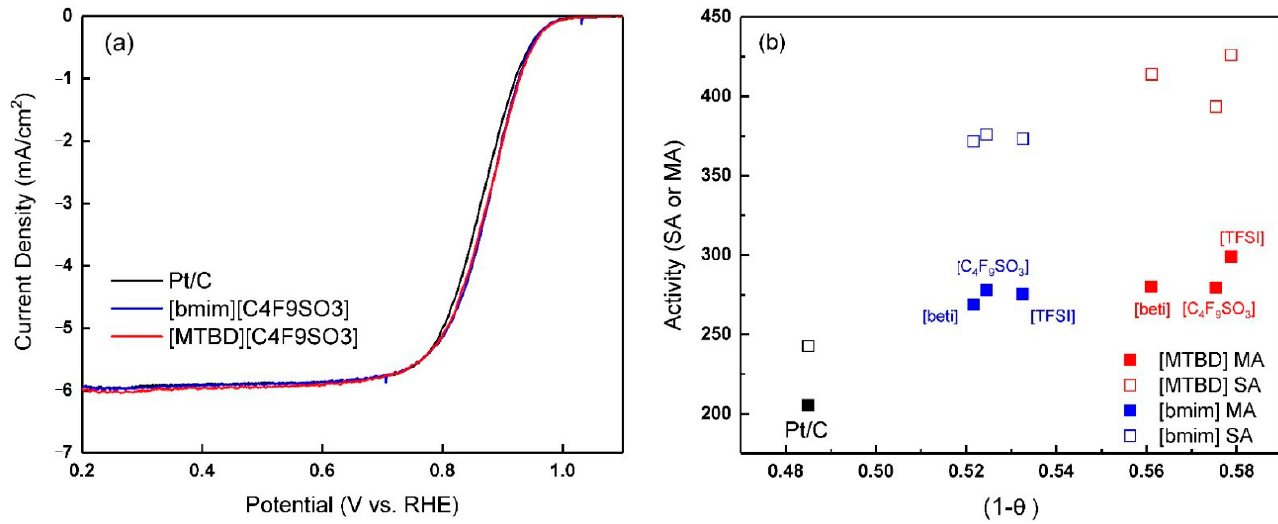
Figure 8. ORR activity measurements. ( a ) Polarization curves of Pt/C, Pt/C-[bmim] [C 4 F 9 SO 3 ], and Pt/C-[MTBD][C 4 F 9 SO 3 ]. ( b ) plots of Mass activity (MA, mA/mg Pt ) and Specific activity (SA, uA/cm 2 Pt ) as a function of (1 − θ ).